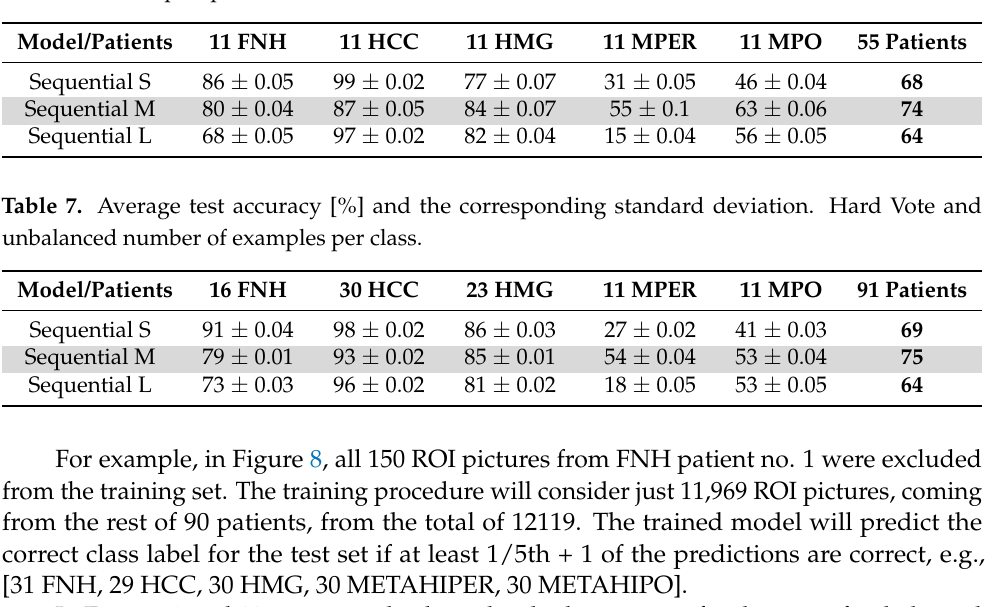
Figure 8. Transfer learning vs. train from scratch paradigm.